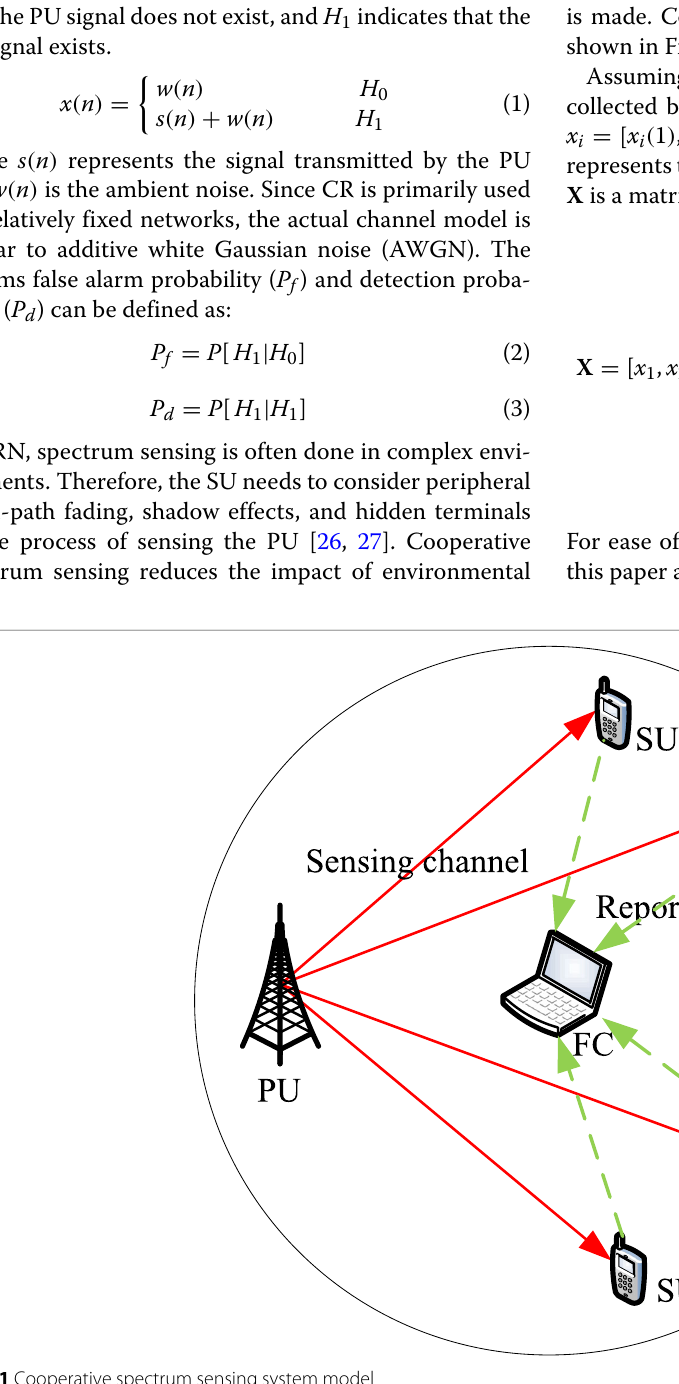
Fig. 1 Cooperative spectrum sensing system